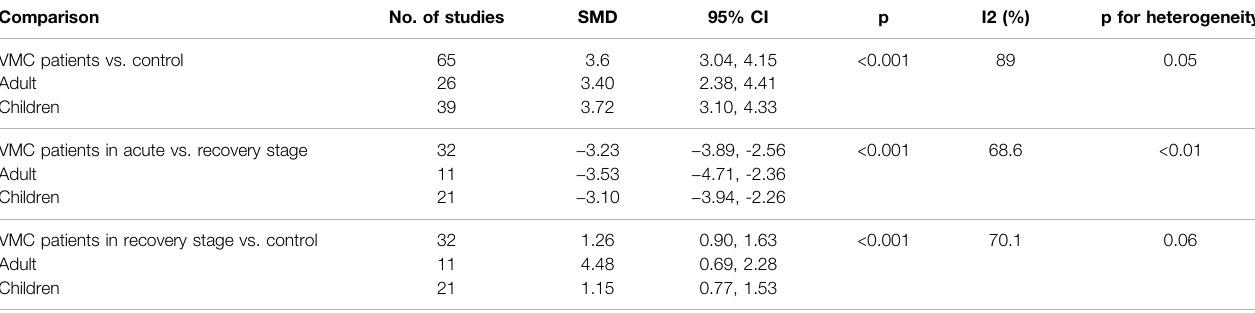
TABLE 2 | Pooled analysis of TNF- α level in comparison to a different stage and subgroup analysis based on age